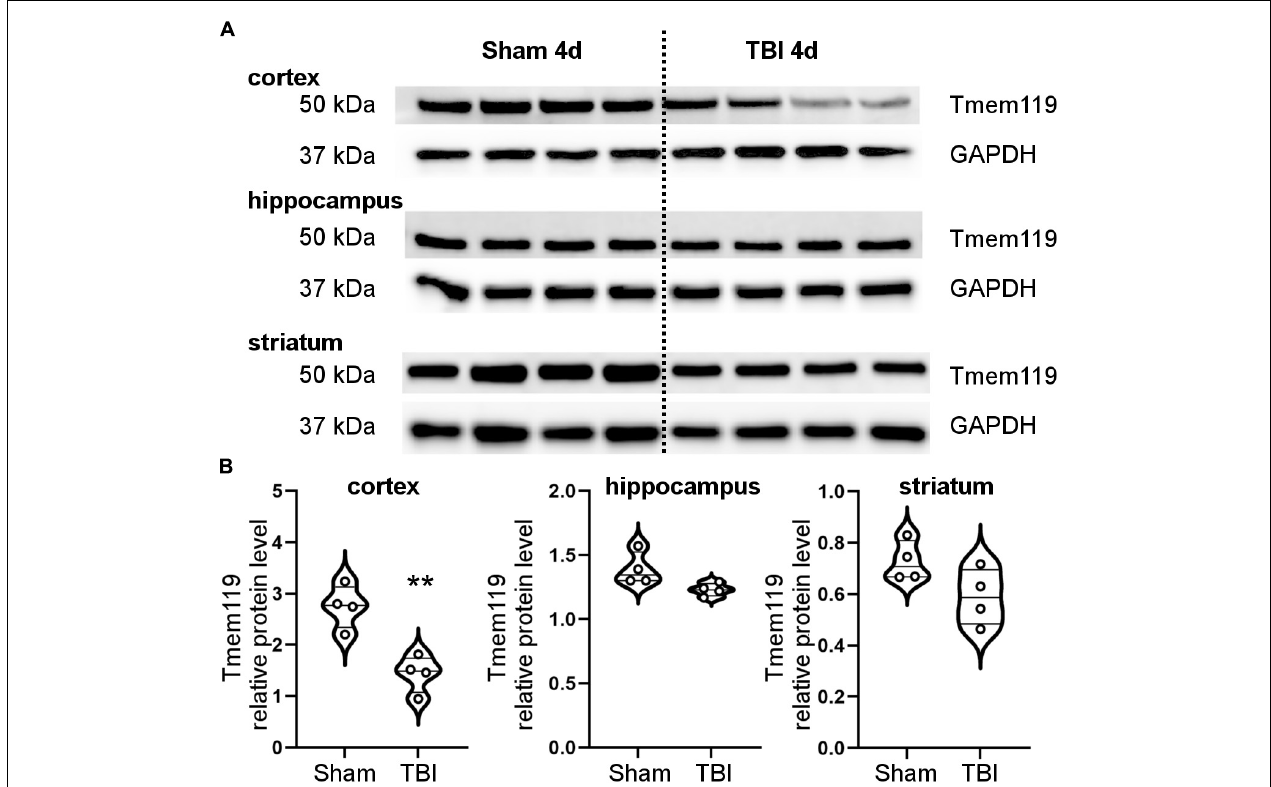
FIGURE 2 | Brain protein levels of Tmem119 at 4 days after sham surgery or TBI. (A) Western blot showing Tmem119 protein (50 kDa) in three different brain regions ipsilateral to the lesion: cortex, hippocampus, and striatum. The GAPDH was used as a loading control. (B) Tmem119 protein levels decreased significantly after TBI selectively in the cortex. Data are shown as violin plot with single replicates, a line at median and quartiles, and n = 4. Unpaired t -test, ** p < 0.01 vs.